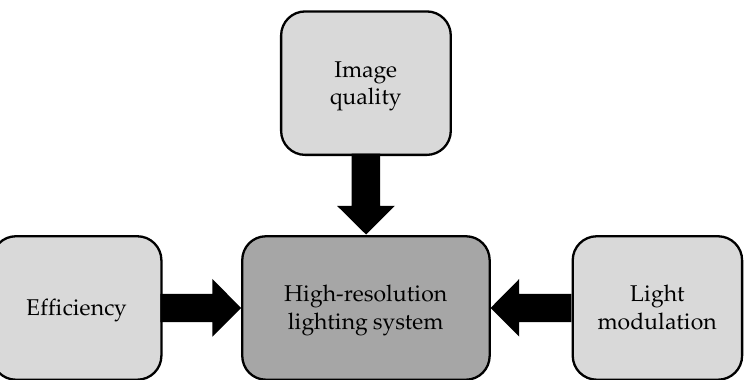
Figure 3. Challenges in the development of high-resolution lighting